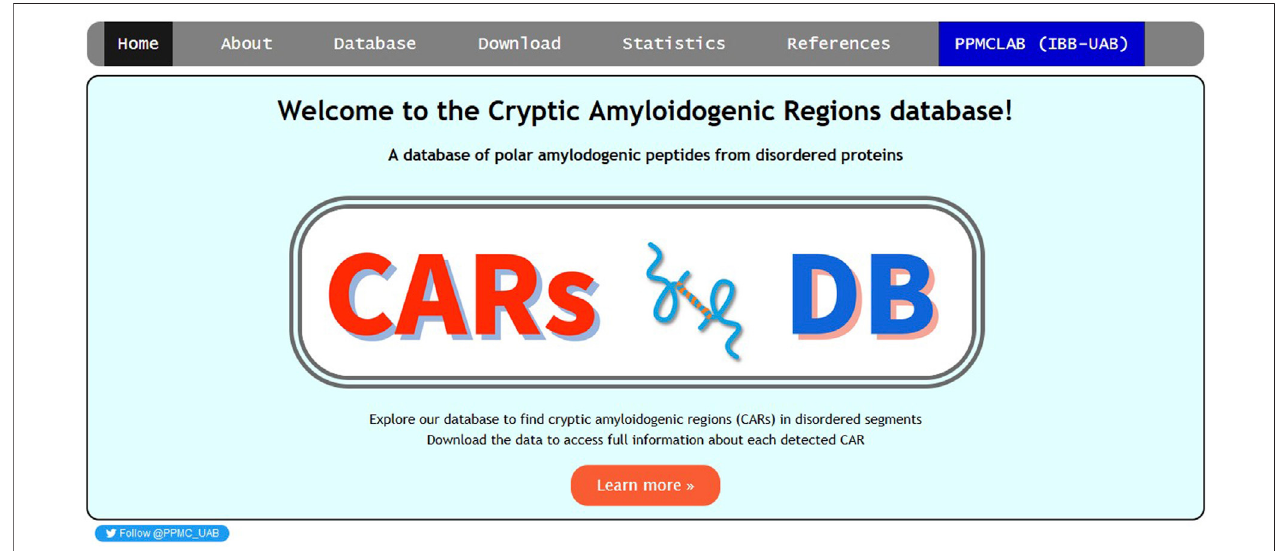
FIGURE 1 | Screenshot of the homepage of the CARs-DB database. Different sections can be accessed to explore the features and content of the database through the navigation bar on the top of the site.